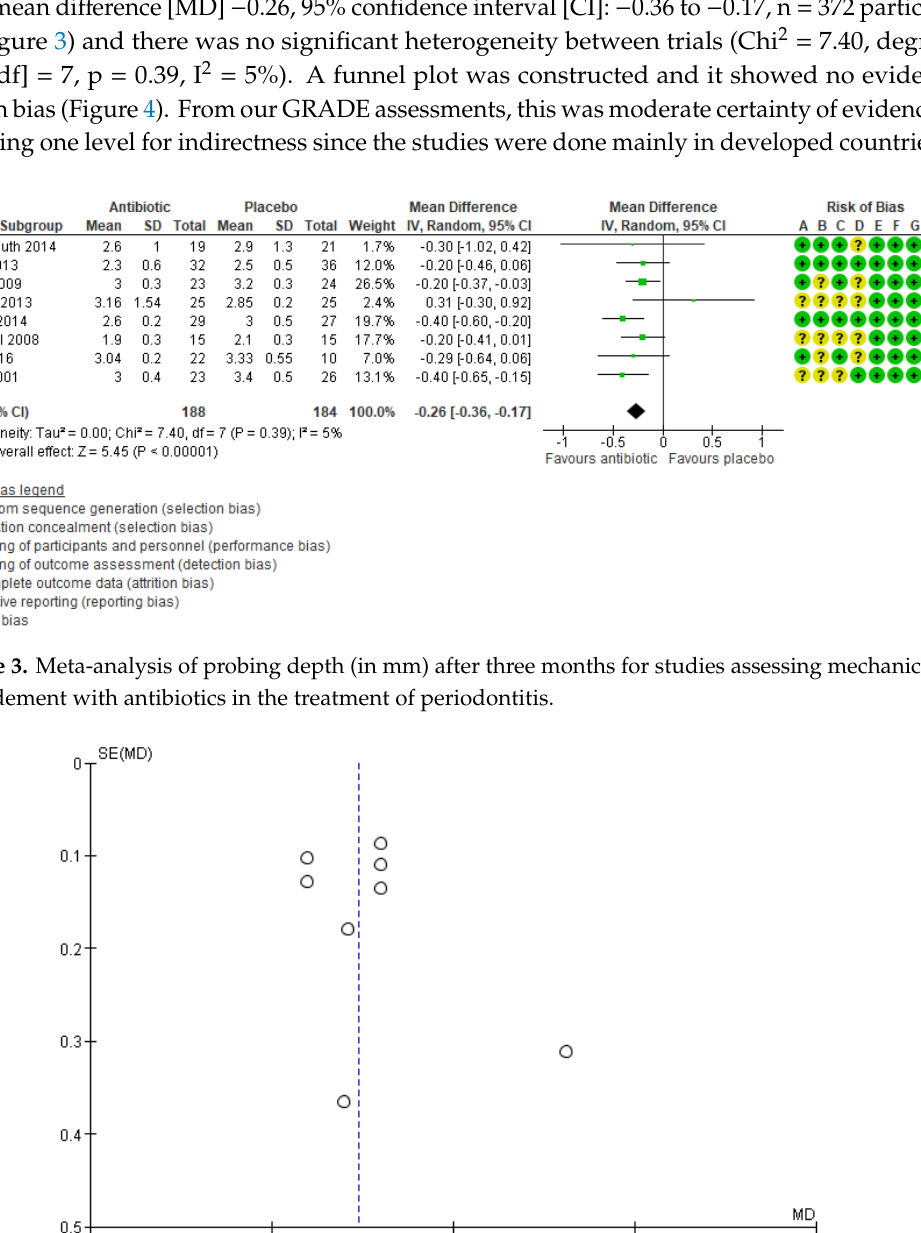
Figure 4. Funnel plot for the meta-analysis of probing depth (in mm) after three months of treatment with either antibiotics or placebo among adult chronic periodontitis patients.